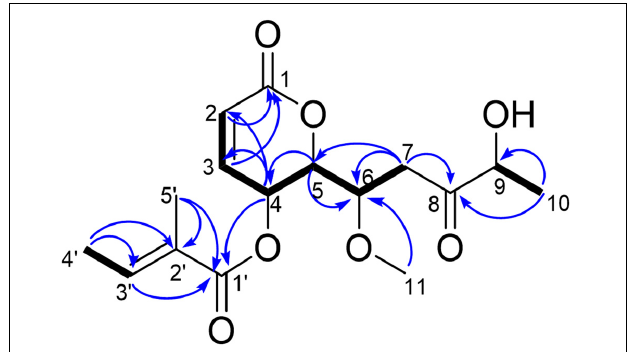
FIGURE 4 | Key HMBC (blue arrow) and 1 H– 1 H COSY correlations (black bond) of 1 .